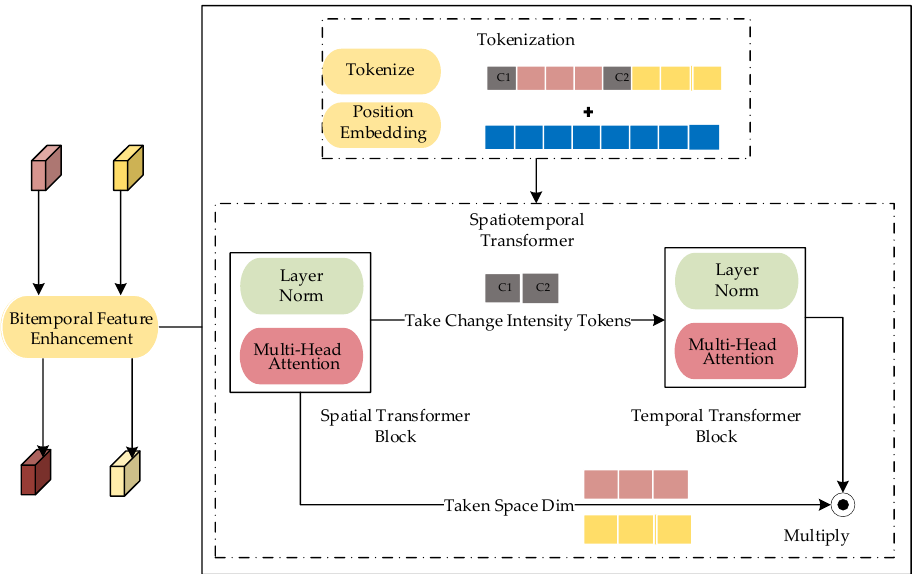
Figure 6. Bitemporal feature enhancement module, where c1 and c2 are the change intensity tokens of the pre- and post-feature maps, respectively. of the pre- and post-feature maps,